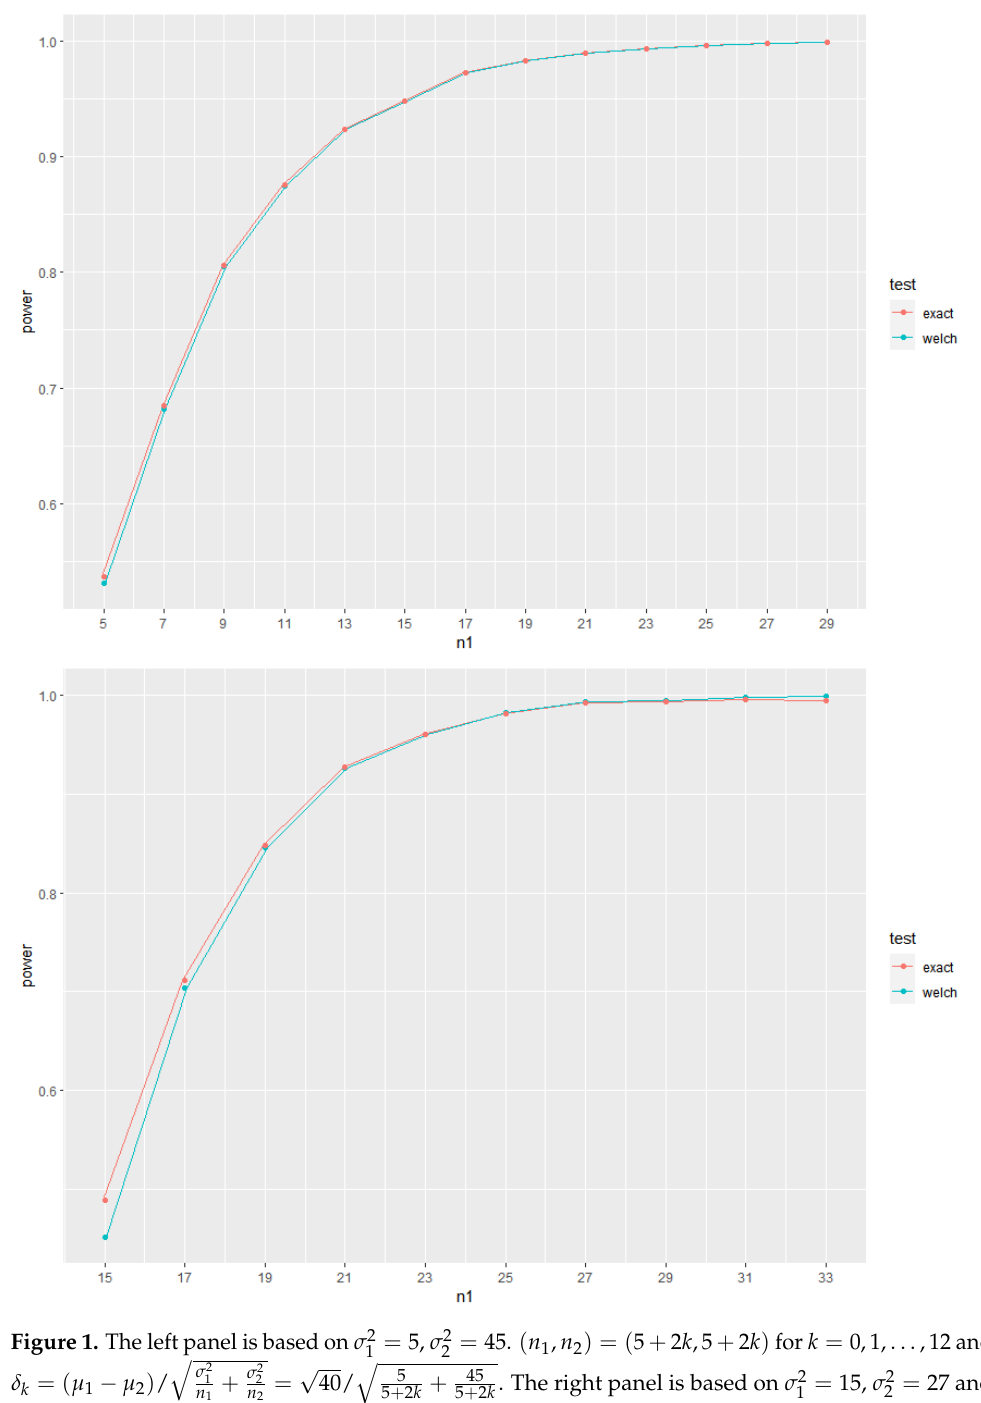
Figure 1. The left panel is based on σ 2 δ k = ( µ 1 − µ 2 ) / ( n ) = ( 15 + 2 k ,3 + 2 k ) for k = 0,1, . . . ,9 and δ 1 , n 2 Red and blue lines represent the power curves from exact distribution and Welch’s test,